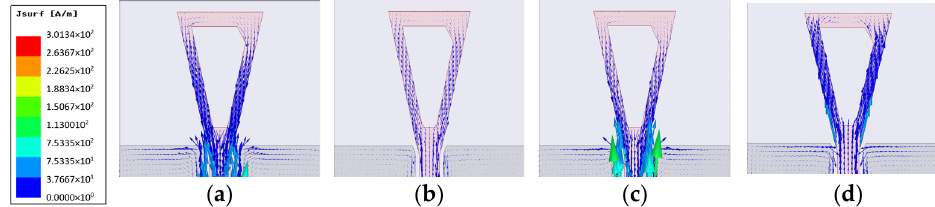
Figure 9. Surface current vector distribution of the proposed CPMS within CP frequency band ( a ) 2.2 GHz, ( b ) 2.4 GHz, ( c ) 2.5 GHz, and ( d ) 3.5 GHz.